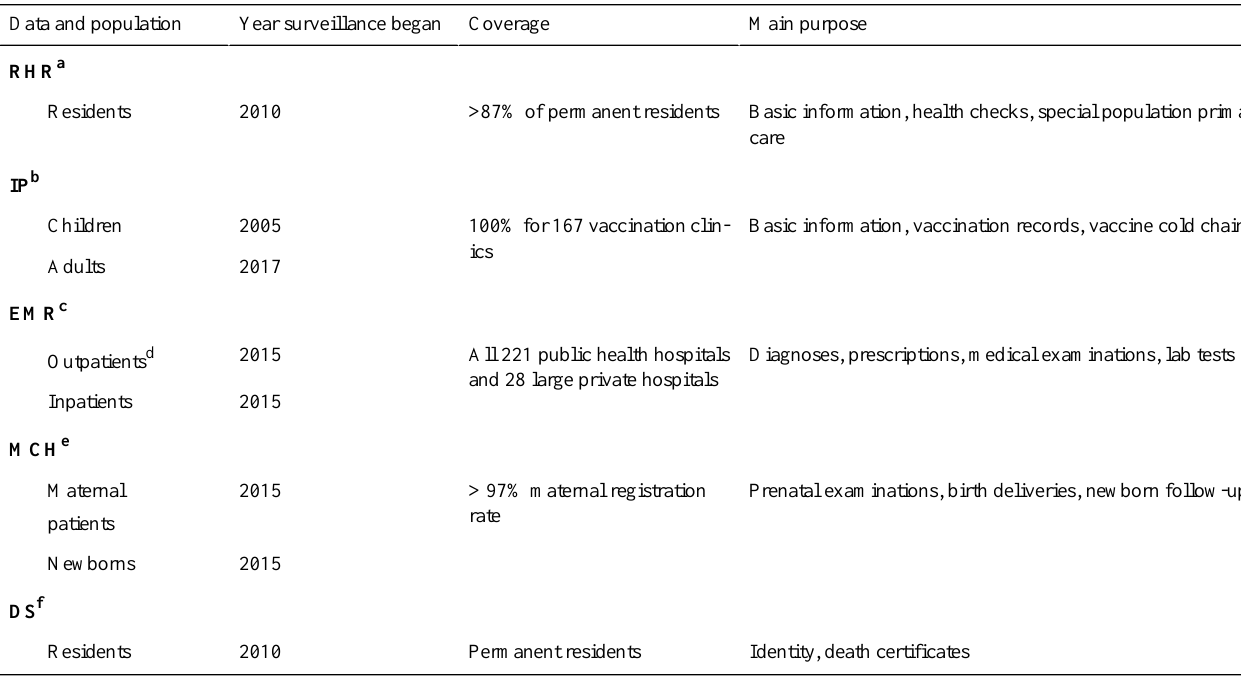
Table 1. Characteristics of the data sources related to HPV vaccine safety surveillance.